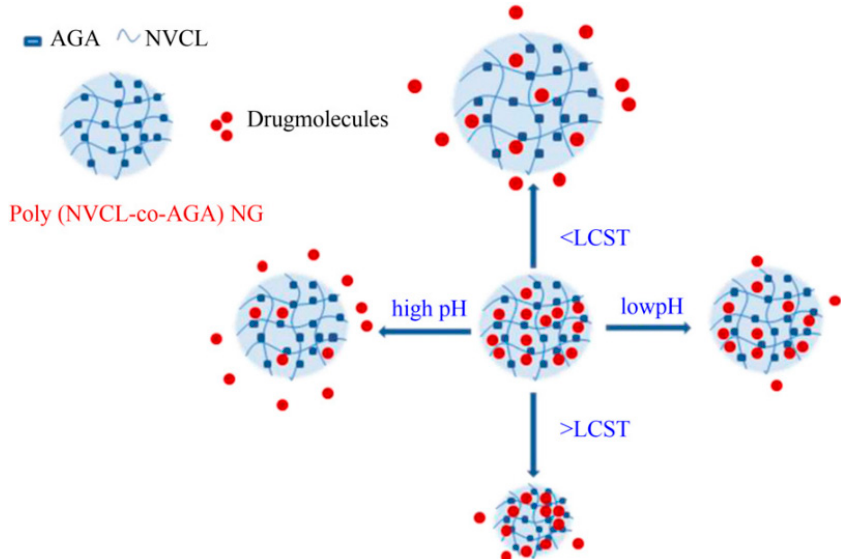
Figure 6. Dual-responsive nanogels based on N-vinyl caprolactam (VCL), which illustrate an increase in drug release at high pH, and the polymer network structure is collapsed at high temperature resulting in lower drug release. Adapted from Ref. [106] reproduced by permission of Elsevier.